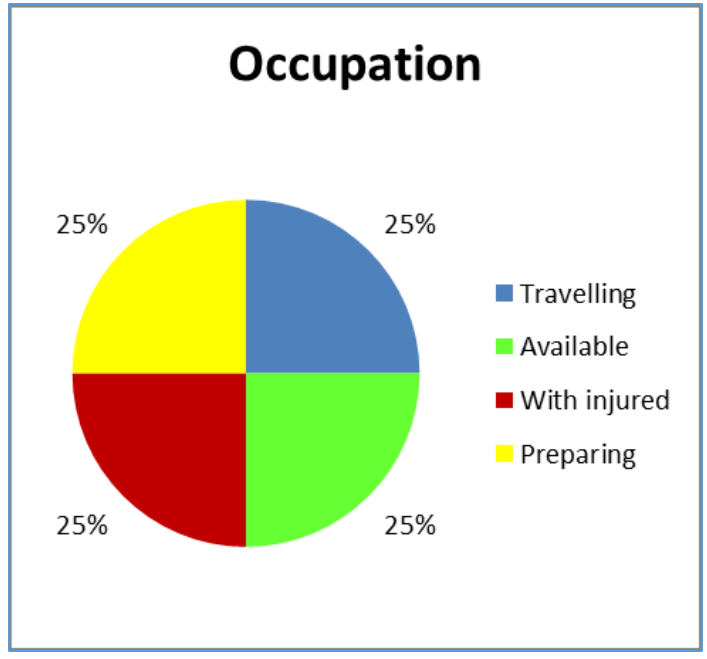
Figure 6. A representative pie-chart of possible states of the